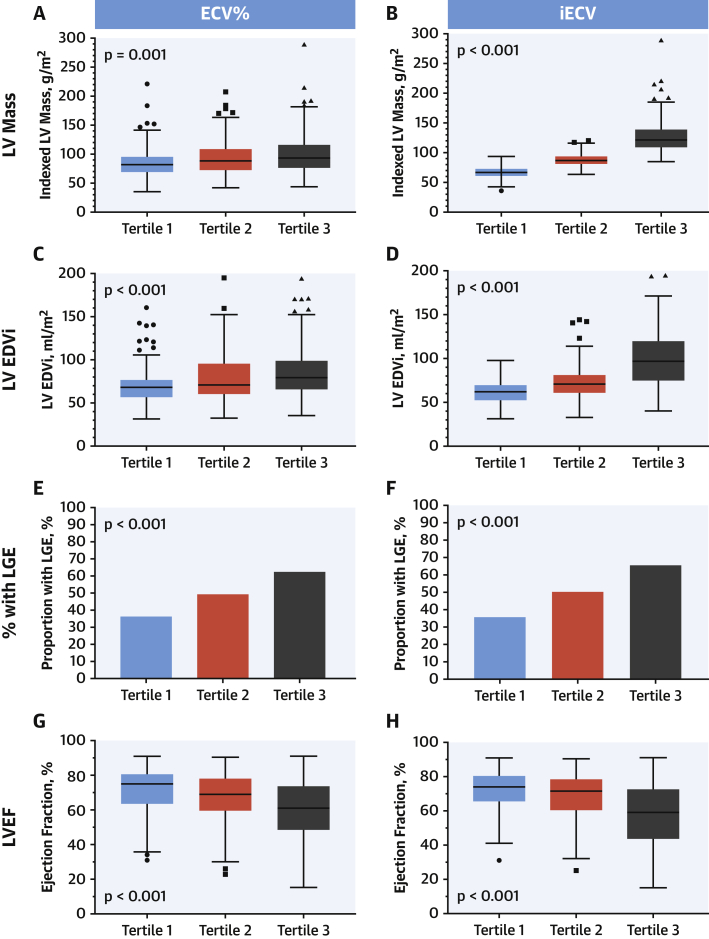
Markers of LV Decompensation Across ECV% and iECV TertilesWhen comparing clinical and imaging variables across extracellular volume fraction (ECV%) tertiles, there was a progressive increase in LV mass (A), LV end-diastolic volume (C), and proportion of patients with late gadolinium enhancement (E), with a reduction in LVEF (G). A similar pattern was seen when comparing these characteristics across tertiles of indexed extracellular volume (iECV) (B, D, F, and H). EDVi = indexed end-diastolic volume; LGE = late gadolinium enhancement; LV = left ventricle; LVEF = left ventricular ejection fraction.